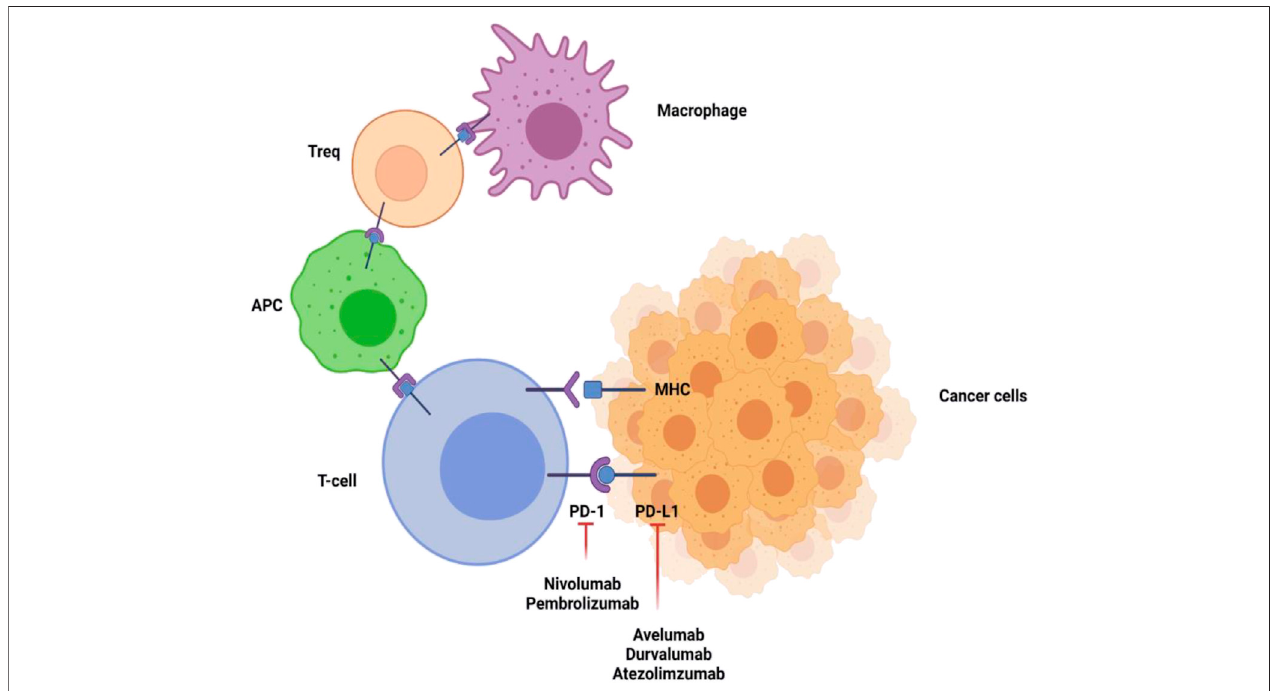
FIGURE 2 | Inhibitory signaling of PD-1 and PD-L1 inhibitors. PD-1 is present on T-cells, antigen presenting cells, macrophages, and regulatory T-cells (T regs ). Linkage ofPD-1with its ligandsresults in downregulation ofproliferation and immune responseofT-cells. Inhibiting the PD-1or PD-L1 pathway reversesthisaction and upregulates immune activity. The fi gure was created with